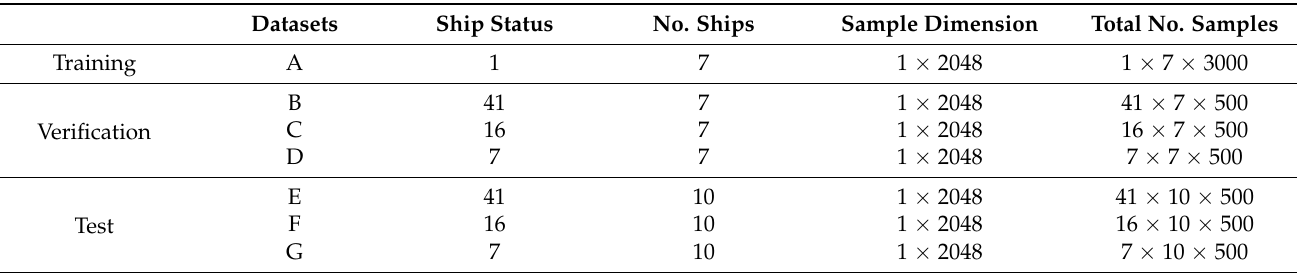
Table 1. The dimensions of datasets A to